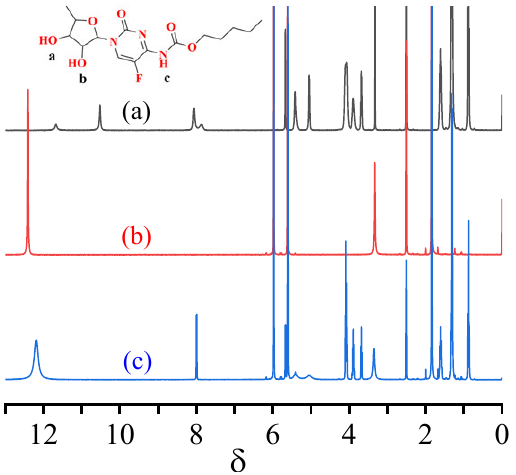
Figure 6. H-NMR spectra of CAP (a), MAA (b), and CAP-MAA (c) in d 6 -DMSO.